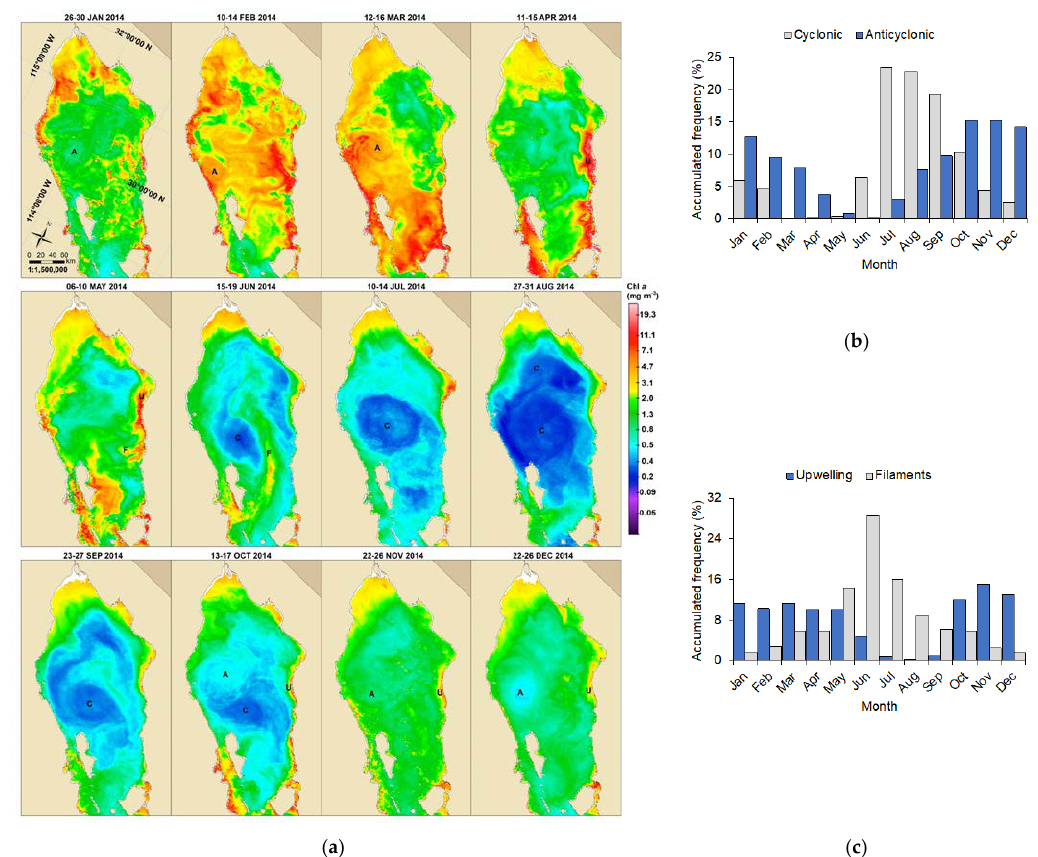
Figure 2. Annual frequency of mesoscale events in the Northern Gulf of California. ( a ) Satellite images of chlorophyll a concentration (mg m − 3 ) characterizing a typical year (2014) for anticyclonic eddies (A), cyclonic eddies (C), coastal upwelling (U), filament (F); Percentage of the accumulated annual frequency of ( b ) cyclonic and anticyclonic eddies; ( c ) coastal upwelling and filaments.